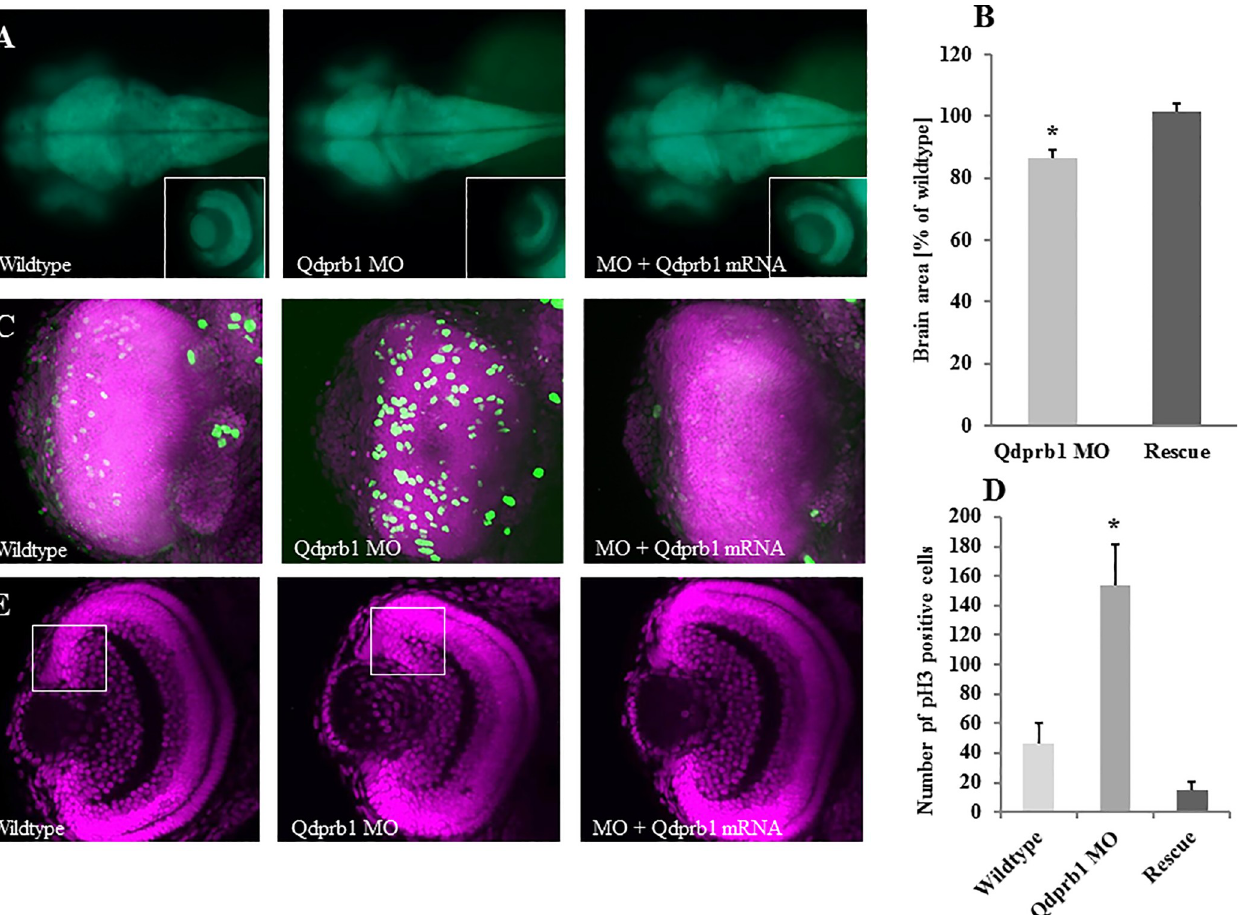
Fig 4. Reduced brain size but increased number of pH3-positive cells upon qdprb1 knockdown. (A) Dorsal views, anterior to the left. At 3 dpf tg(HuC/D: GFP) transgenic zebrafish show a decreased size of the optic tectum and eye upon qdprb1 knockdown, which can be rescued by co-injecting qdprb1 mRNA. The insets show dorsal views of the left eye, which is reduced in size but still layered upon qdprb1 suppression. This phenotype is rescued upon co-injection of qdprb1 mRNA. The overall GFP signal remains unchanged. (B) The brain area of Qdprb1 hypormorphic embryos is reduced by about 15% compared to wildtypes and rescued by co-injection of qdprb1 mRNA. (C) Z-stack overlays of DAPI (pink) and pH3 (green) staining of dorsally imaged retinas reveal an increased number of pH3-positive retinal cells in Qdprb1 hypormorphic embryos (3 dpf), which are not restricted to the CMZ like found in wildtype retinas. Number and distribution of pH3-positive cells is restored by co-injection of qdprb1 mRNA. (D) Statistical analysis shows a significant increase in pH3 positive cells upon qdprb1 knockdown (n = 6) in comparison to wildtype zebrafish (n = 7), which could be rescued by addition of qdprb1 mRNA (n = 3). (E) Z-confocal image of DAPI staining (pink) of the retina at 3 dpf shows retinal layers although decreased overall size and broadened CMZ in qdprb1 hypomorphic embryos.